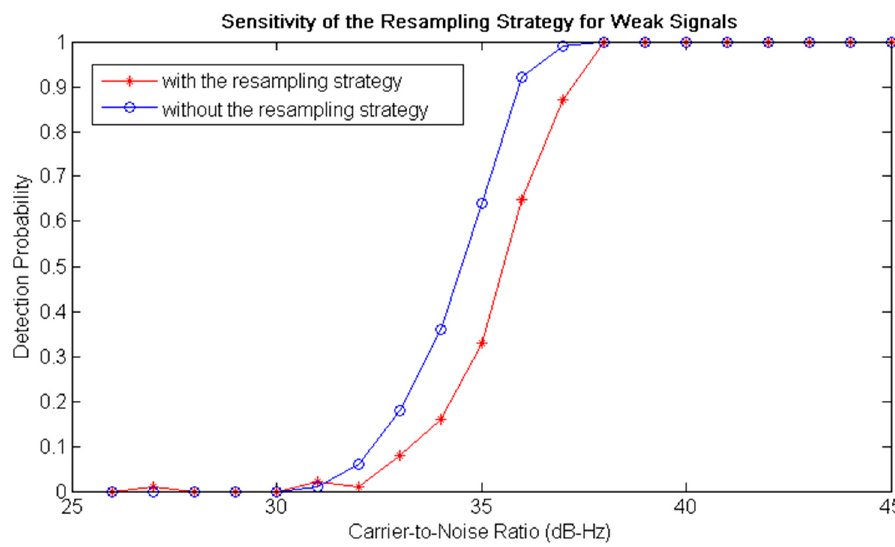
Figure 10. Sensitivity of the resampling strategy for weak signals. The red plot is the detection probability of signal acquisition with the resampling strategy, and the blue one is that of the conventional acquisition algorithm (without the resampling strategy). Table 3. Sampling frequency, computation, and time cost of signal acquisition without/with the resampling strategy for the received broadband signals of different experimental datasets.